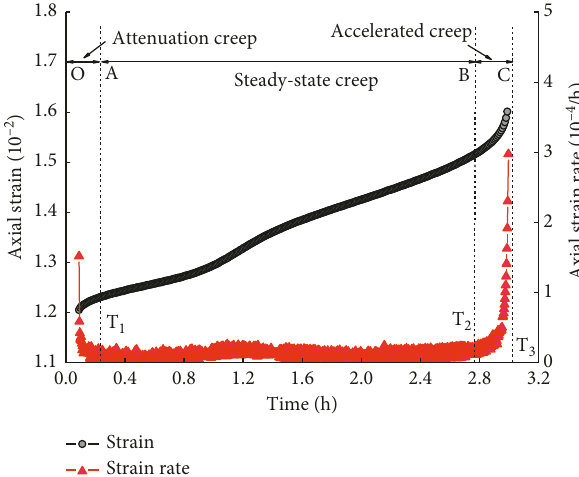
Figure 12: Creep-strain rate versus time (specimen S7, − 10 °